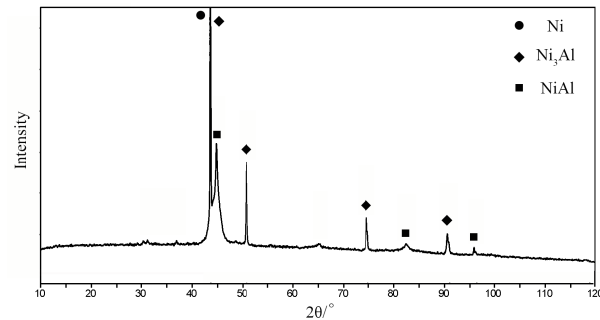
Figure 5. XRD pattern of the Y-modified NiCrAlY coating.